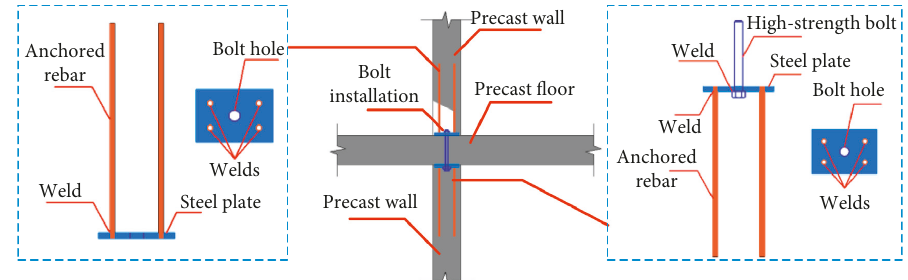
Figure 2: Details of the connection joint of the precast components.